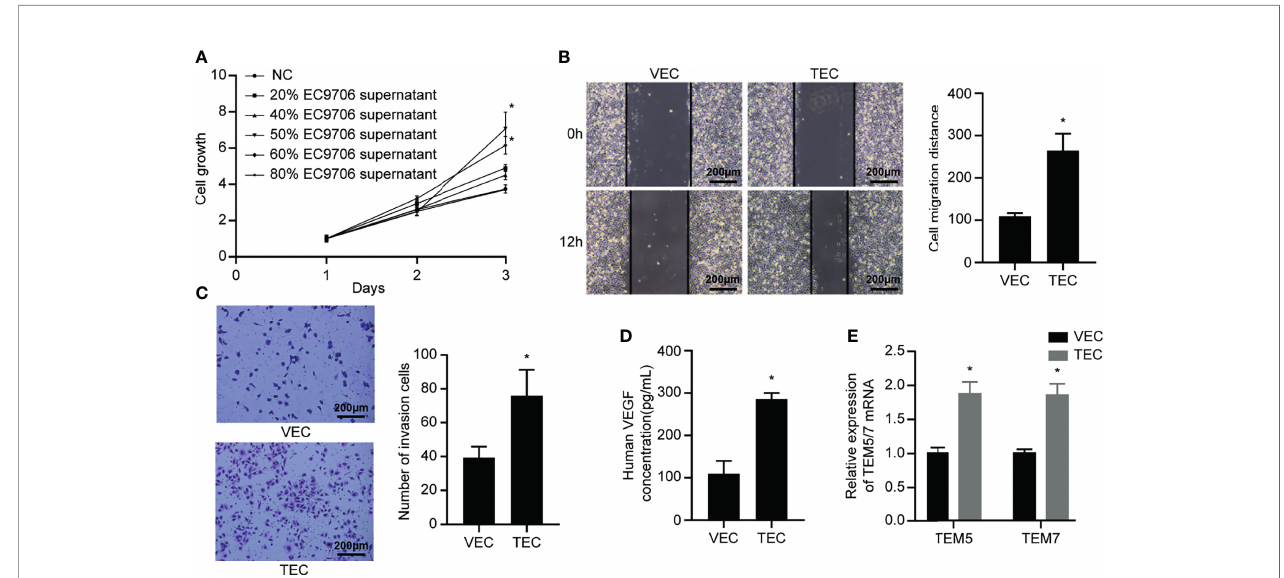
FIGURE 6 | VECs cultured in conditioned medium to induce TECs. (A) Proliferation ability of TECs induced by different concentrations of conditioned medium; (B) Migration ability of VECs and TECs (100×); (C) Invasion ability of VECs and TECs (100×); (D) VEGF content in the supernatant of VECs and TECs; (E) Levels of tumor endothelial markers in VECs and TECs. * p < 0.05 compared to